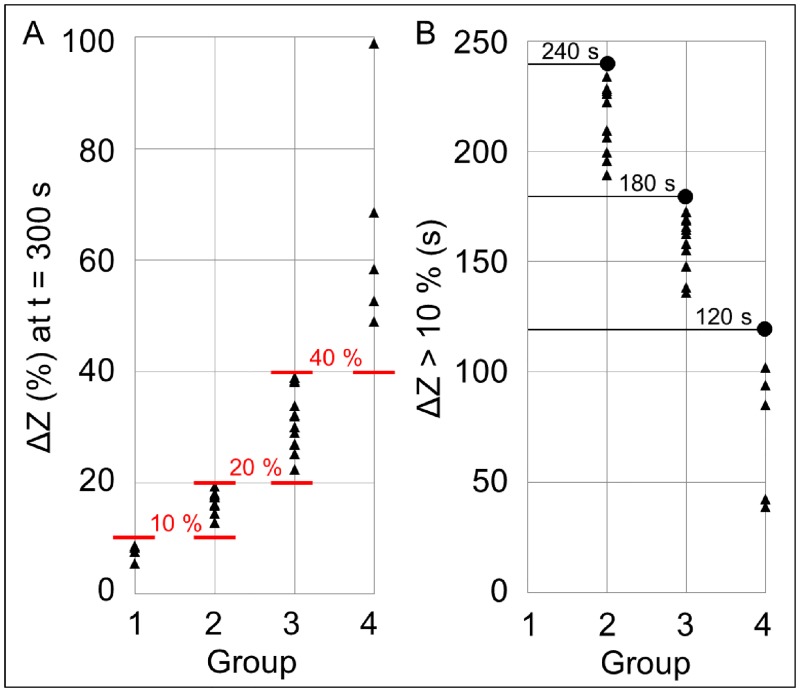
Extraction of classification thresholds.The overall increase of the impedance magnitude within 300 seconds and the intermediate time instant of 10% threshold overpassing are experimentally defined, for each group, from the corresponding values of each experiment. Group 1: ΔZ = 7.55 ± 1.42% (always < 10%). Group 2: ΔZ = 16.55 ± 1.88% (10% < ΔZ < 20%); ΔZ > 10% at t = 213.83 ± 15.76 s (dot at t = 240 s). Group 3: ΔZ = 31.15 ± 5.43% (20% < ΔZ < 40%); ΔZ > 10% at t = 159.32 ± 12.63 s (dot at t = 180 s). Group 4: ΔZ = 65.46 ± 20.12% (ΔZ > 40%); ΔZ > 10% at t = 72.37 ± 29.81 s (dot at t = 120 s).